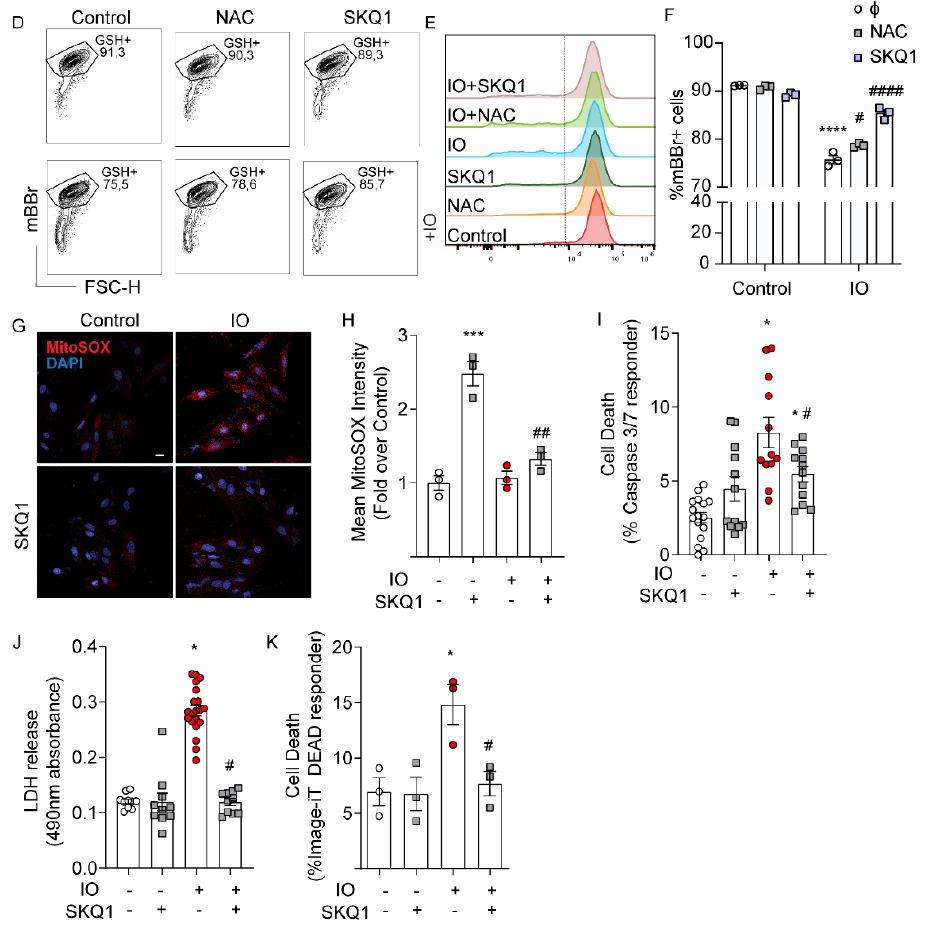
Figure 3. Mitochondrial ROS contributes to cell death induced by iron-overload. H9c2 cells were treated with FeSO 4 (100 µ M, 24 h) with or without SkQ1 (20 nM, 24 h, plus 30 min prior) co-treatment versus Control (DMEM + 0.5% FBS). ( A – C ) Flow cytometry analysis with MitoSOX Red. ( A ) Flow cytometry gating for MitoSOX-positive cells. ( B ) Overlayed histograms showing the mean fluorescence intensity (MFI): right of the line are positive cells for increased mitochondrial ROS ( C ) Graphical representation of MitoSOX-positive cells. ( D ) Flow cytometry gating for mBBR-labeled cells (GSH+). ( E ) Overlayed histograms showing the mean fluorescence intensity (MFI), right of the line are cells positive for mBBR-GSH interaction. ( F ) Graphical representation of mBBR-positive cells from three experiments like that shown in panel D. ( G ) Analysis of mitochondrial ROS by confocal analysis using MitoSOX Red staining. ( H ) Quantification of mean puncta intensity of MitoSOX Red staining (n = 3). ( I ) Quantification of mean puncta intensity for Caspase 3/7 cleavage as % of total nuclei, using the CellEvent Caspase 3/7 Detection kit (n = 4). ( J ) LDH release assay and ( K ) Image-iT DEAD assay examining the effect of SkQ1 on IO-induced cell death (n = 4). Scale bar in G denotes 20 µm. * p < 0.05, *** p < 0.001, **** p < 0.0001 relative to Control; # p < 0.05, ## p < 0.01, #### p < 0.0001, relative to IO.